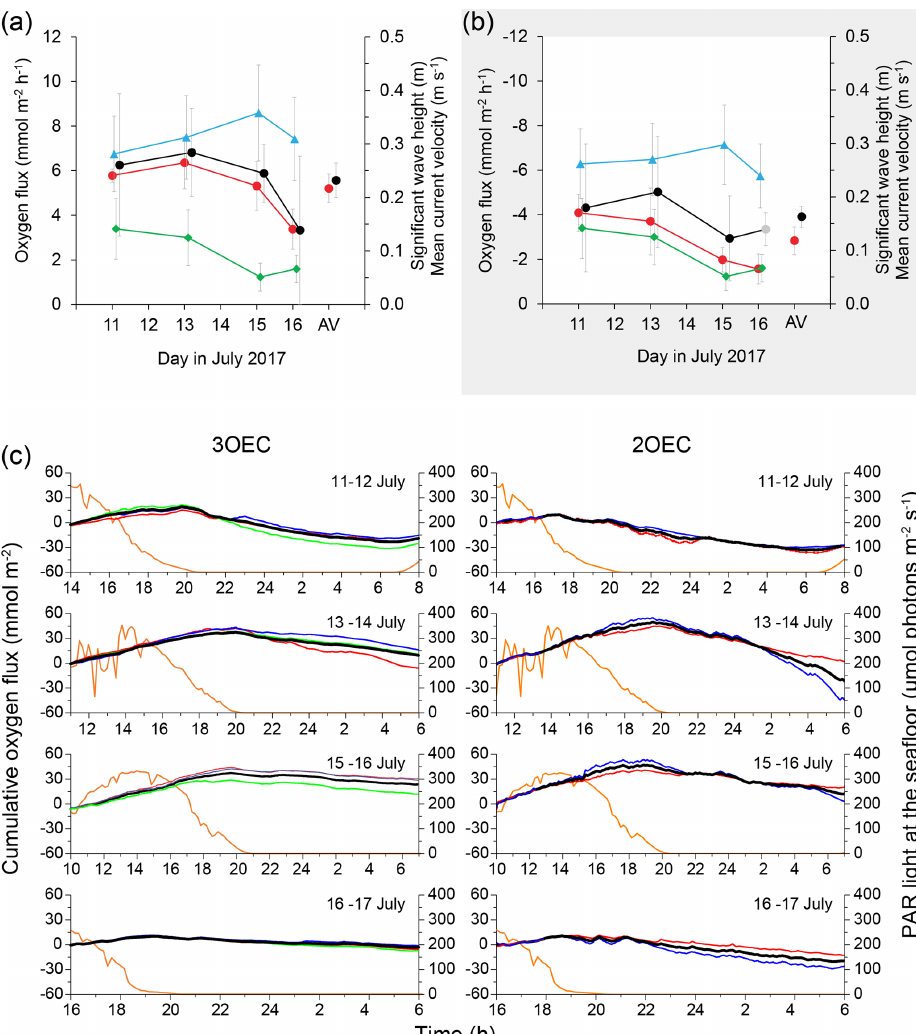
Figure 2. Fluxes and cumulative flux trajectories recorded during the deployment week. (a) Daytime and (b) nighttime O 2 fluxes measured by the 3OEC (red circles and line) and 2OEC (black circles and line), as well as significant wave heights (light blue triangles and line) and current flows (green diamonds and line) recorded in July 2017. Note reversed y axis scale for (b) night fluxes. Grey circle in (b) indicates data point compromised by sensor deterioration. Error bars depict standard deviation except for the 11–16 July averages (single circles on right side of panels), for which error bars present standard error. (c) Comparison of cumulative fluxes measured by the 3OEC (left column) and 2OEC (right column) on 11–12, 13–14, 15–16, and 16–17 July (top to bottom) with the respective light (PAR) intensities (orange lines) at the seafloor. Sensor 1: red; sensor 2: blue; sensor 3: green; average sensor signals: thick black